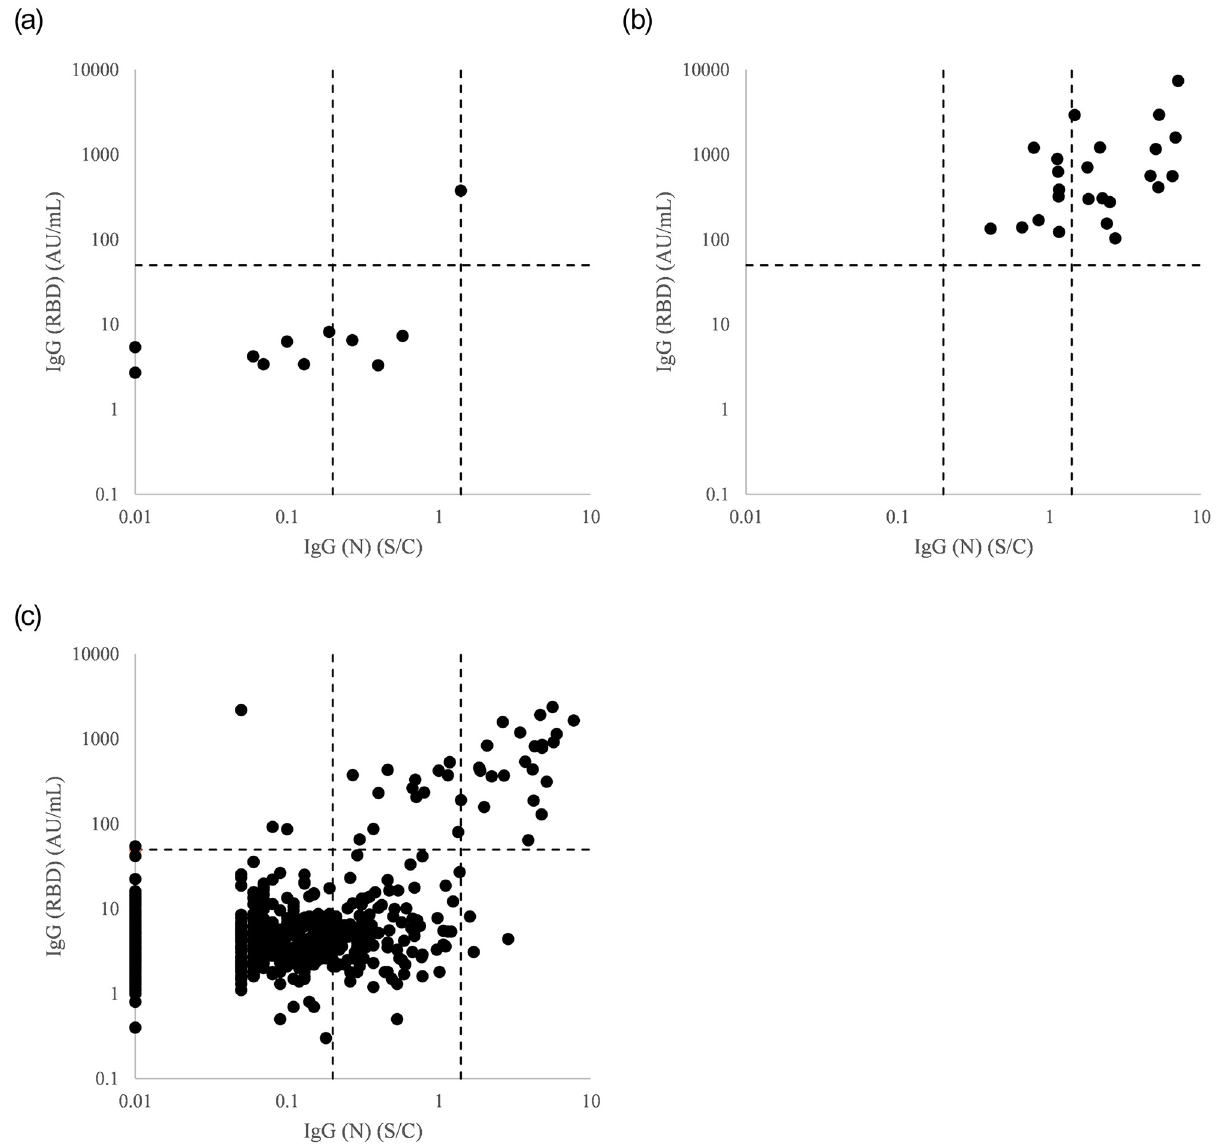
Fig 2. Distribution of IgG titers in healthcare workers in Tokyo Shinagawa Hospital. IgG (N) and IgG (RBD) titers are plotted on x- and y-axis, respectively. Dotted lines on x-axis are cut-offs of IgG (N) at 0.2 S/C and 1.4 S/C and that on y-axis is a cut-off of IgG (RBD) at 50 AU/mL. (a) Subjects with negative PCR; (b) Subjects with positive PCR; (c) Subjects without symptoms and had not been tested with PCR.